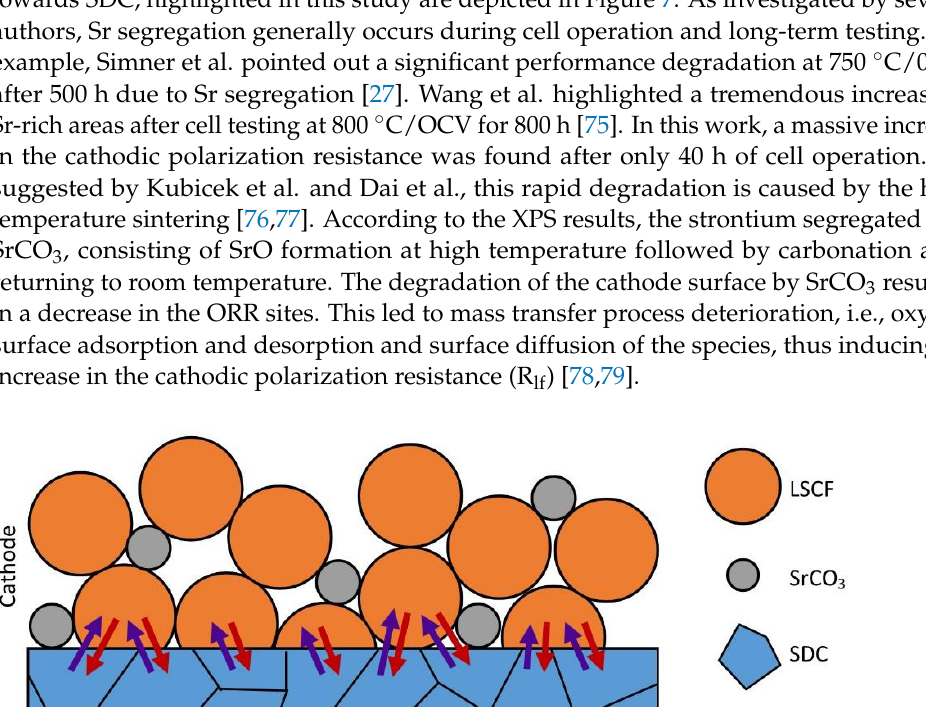
Figure 6. XPS windows spectra of the tested interface and the reference sample ( a ) Ce 3d core-level spectra; ( b ) Sm 3d 5/2 core-level spectra; ( c ) La 3d core-level spectra; ( d ) Sr 3d core-level spectra; ( e ) Fe 2p core-level spectra and ( f ) C 1s core- level spectra.